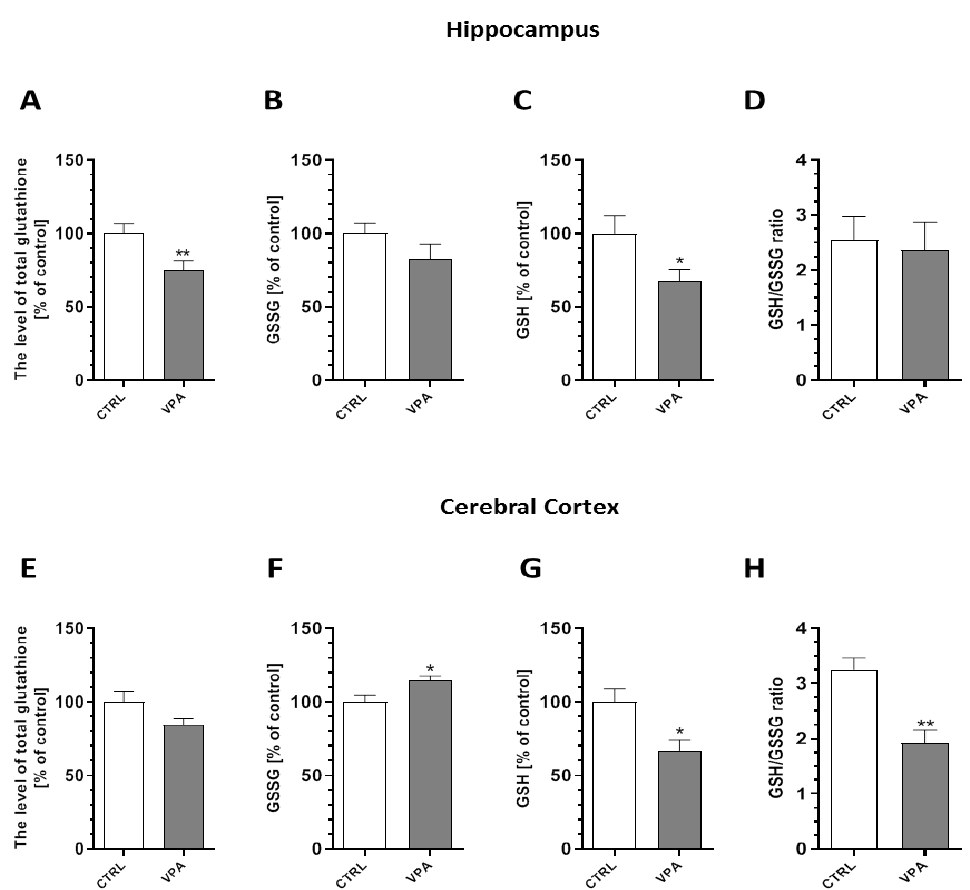
Figure 7. The effect of prenatal exposure to VPA on the glutathione level. The glutathione redox imbalance was determined by spectrophotometric assays. We determined the level of total glutathione, oxidized glutathione (GSSG), reduced glutathione (GSH), and the ratio of GSH/GSSG in the hippocampus ( (A) , (B) , (C), and (D) , respectively), as well as in the cerebral cortex ( (E) , (F) , (G) and (H) , respectively), of the control and VPA-exposed animals. Data represent the mean values ± SEM from n = (10−12) independent experiments in the hippocampus and n = (3−5) in the cerebral cortex. * p < 0.05, ** p < 0.01 vs. control.